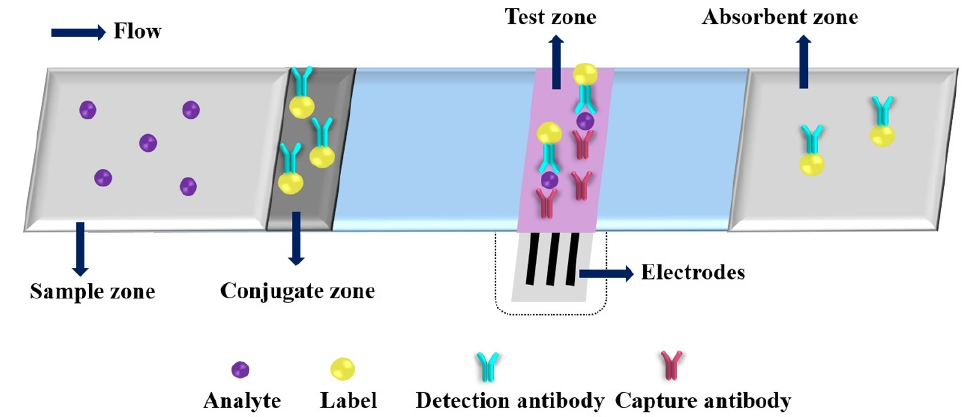
Figure 3. An illustration of a typical electrochemical paper-based analytical device. Table 1. The typical nanomaterial-enhanced ePADs for sensing various analytes.